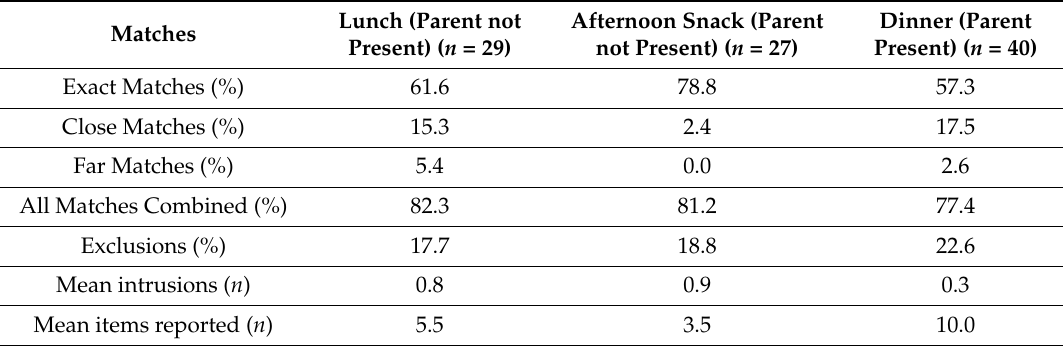
Table 2. Mean proportion of exact, close, and far matches and exclusions and number of intrusions reported by parents ( n = 40) using ASA24-Canada for each meal occasion, in relation to true (observed) intakes. 1 Lunch (Parent